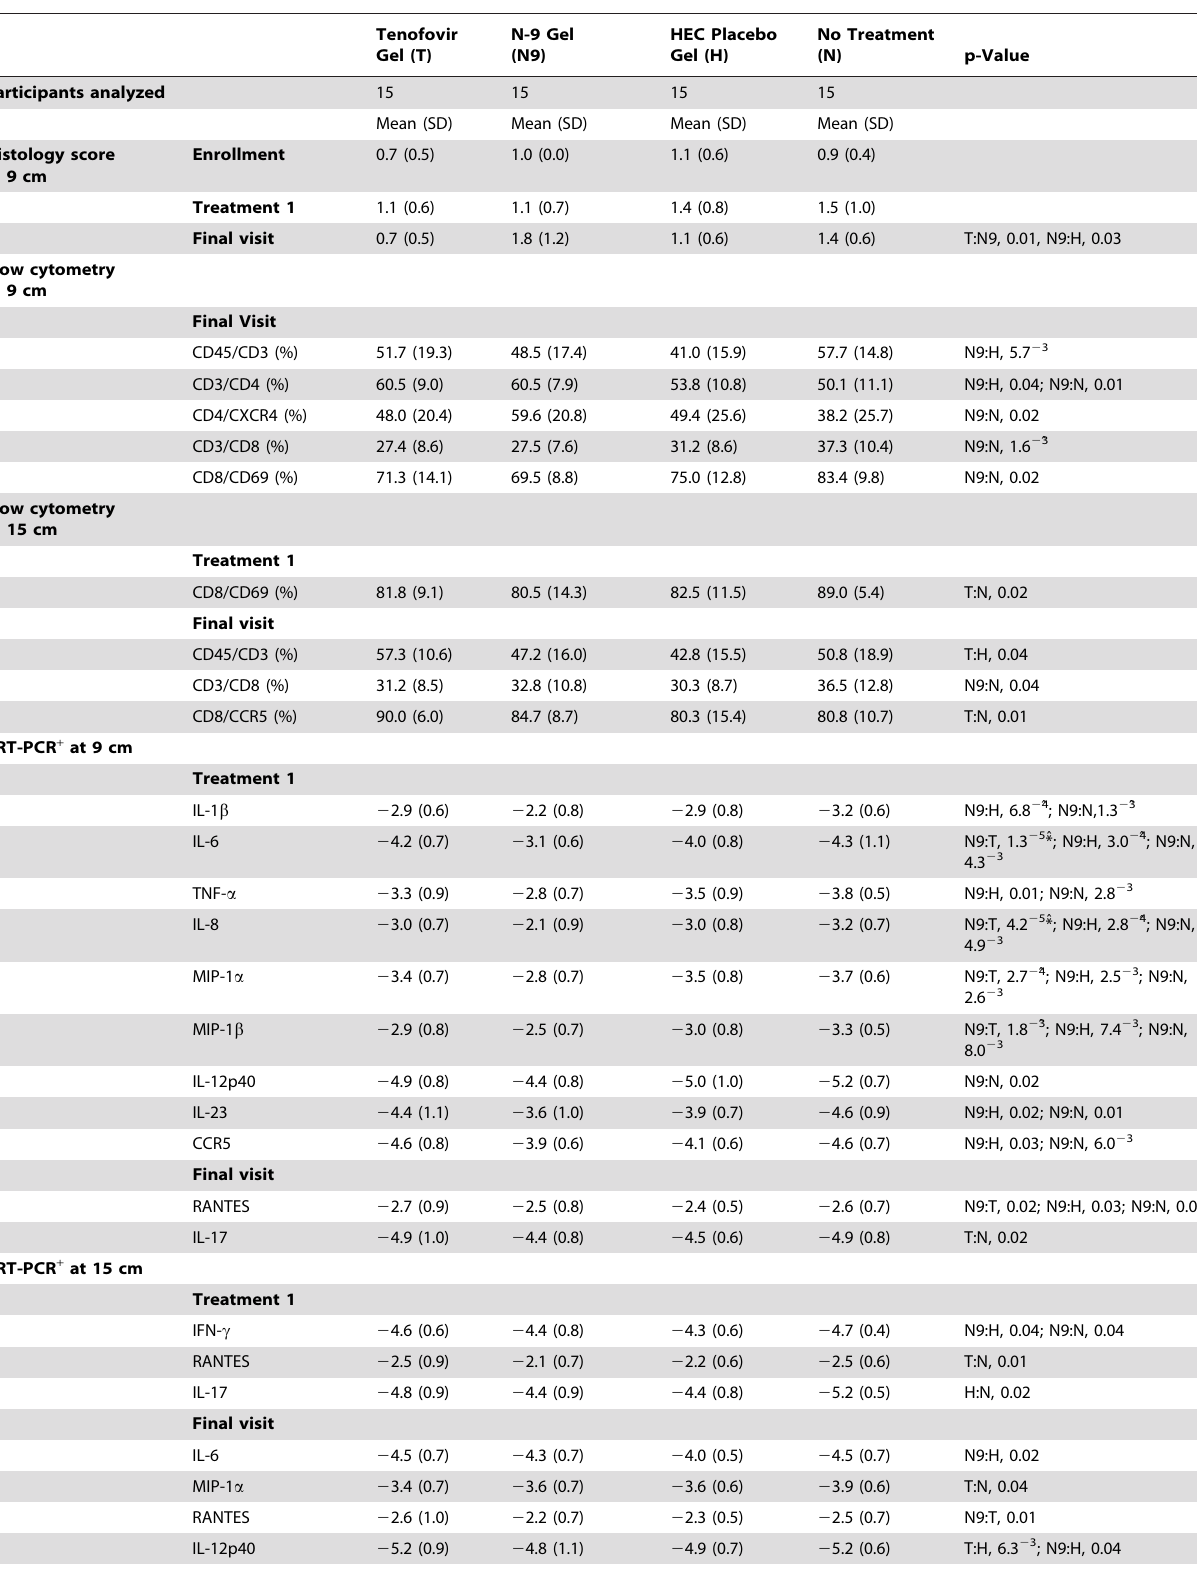
Table 3. Mucosal immunology assays with suggestive evidence of changes with nominal pairwise comparison p-value less than